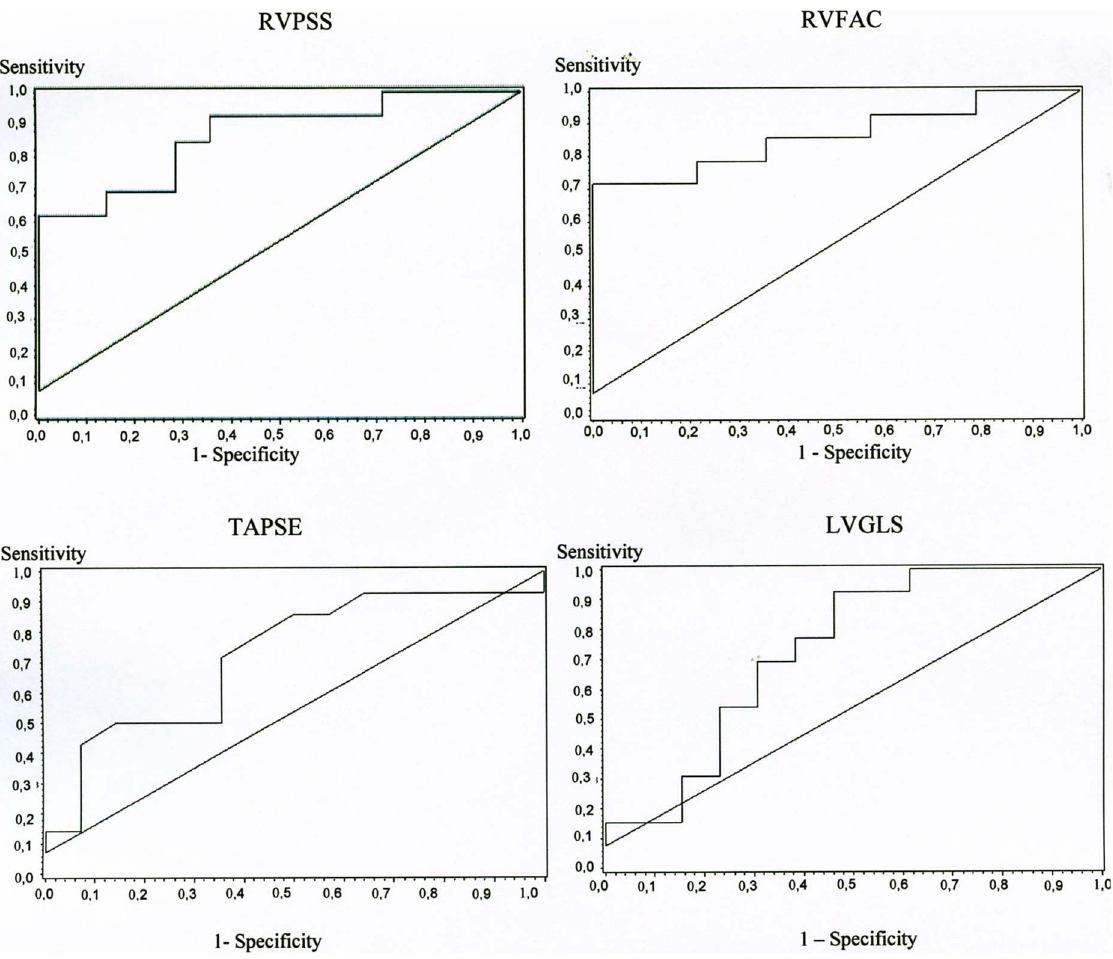
Figure 3. Correlation of RVPSS, RVFAC, TAPSE and LVGLS with occurrence of RV dysfunction displayed by receiver operating characteristic (ROC) curves. RVPSS: right ventricular peak systolic strain, TAPSE: tricuspid annular plane systolic excursion, RVFAC: right ventricular fractional area change, LVGLS: left ventricular global strain.